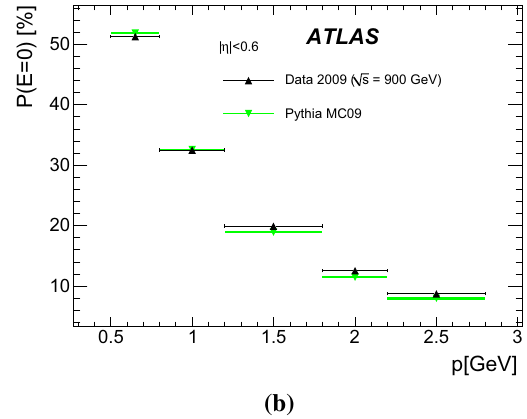
Fig. 20 In a , the likelihood P E = 0 ( d dm ) to find no matching energy in the calorimeter ( E = 0) for reconstructed isolated charged-particle tracksisshownasafunctionofthethickness d dm oftheinactivematerial infrontofthecalorimeter,fordataandMCsimulationsinproton–proton √ s = 900GeV. The thickness of the inactive material is collisions at